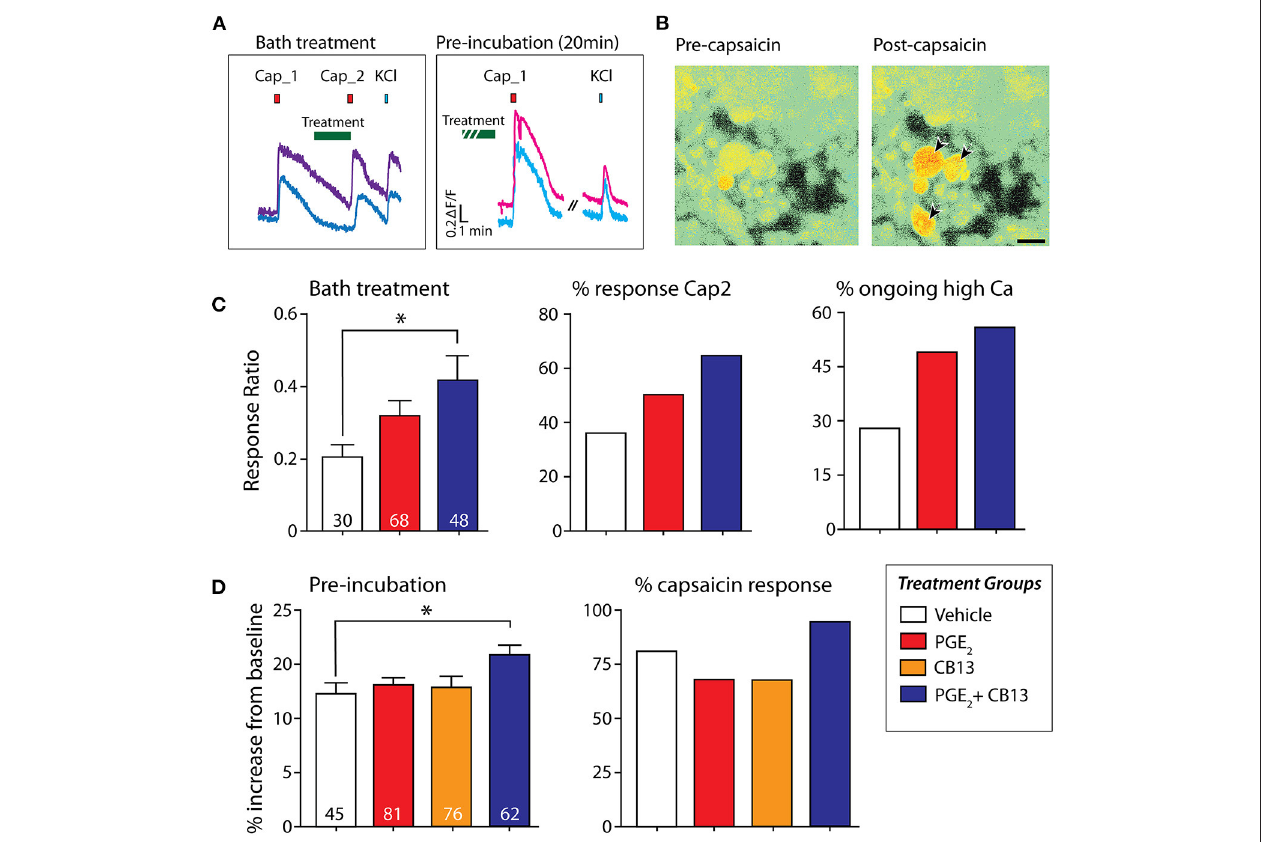
FIGURE 3 | CB13 and PGE 2 interact to enhance sensitization to capsaicin. (A) Example of “bath treatment,” in which treatment is bath-applied in between capsaicin applications, and “pre-incubation,” in which dissociated hDRG are exposed to treatment under incubator conditions for 20min prior to capsaicin. (B) Fura-2AM signal in hDRG neurons showing the response in some cells to 250nM capsaicin (arrows). (C) Bath treatment: Cap2/Cap1 ratio ( left ) one-way ANOVA followed by Dunnett’s post-test shows that PGE 2 + CB13 leads to significantly reduced desensitization ( p = 0.02). Number of cells tested in each group indicated at the bottom of each bar. Center, Percent of cells responding to the second capsaicin application. Right , Percent of cells that did not fall back to baseline within 7min after the first capsaicin application. (D) Pre-incubation: ( Left ) magnitude of peak capsaicin response. One-way ANOVA followed by Dunnett’s post-test shows PGE 2 + CB13 exhibited a larger peak response compared to vehicle. ( Right ) Percent of sensory neurons responsive to capsaicin after 20min of incubation with the various treatments. * p <